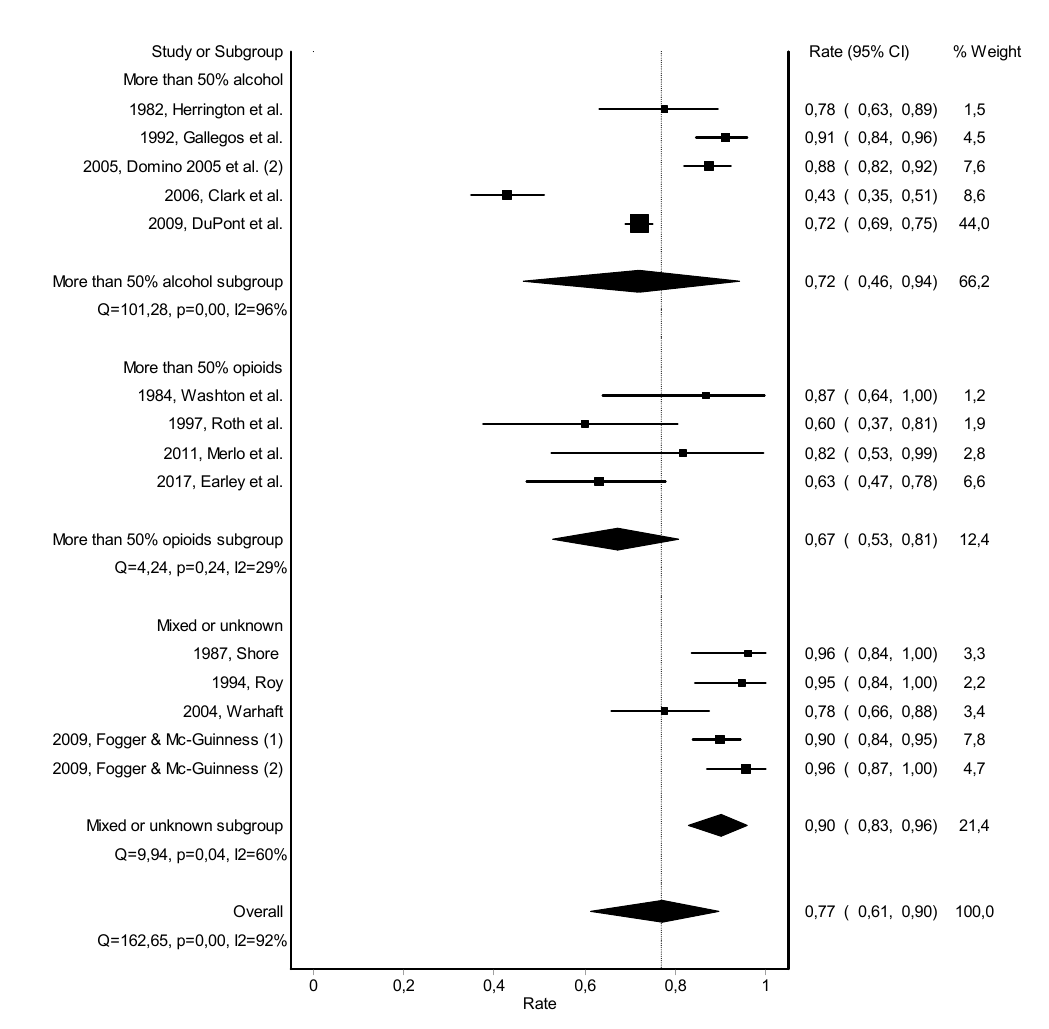
Figure A11. Forest plot of the pooled work retention rate—subgroup analysis based on type of substance use.